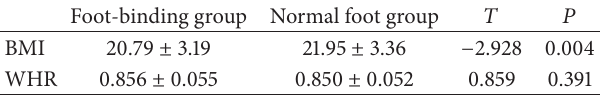
Table 3: Comparison of BMI and WHR of normal foot group ( 𝑛 = 104 ) and foot-binding group ( 𝑛 = 204